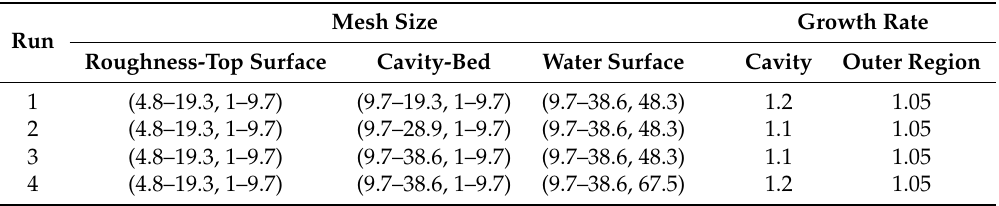
Table 2. Mesh sizes and size growth-rates for the outer region and cavity. In a pair of parentheses, the values are the range of ∆ x 1 , followed by the range of ∆ x 2 , both in dimensionless wall units. The positions of the roughness-top surface, cavity-bed and water surface are marked in Figure